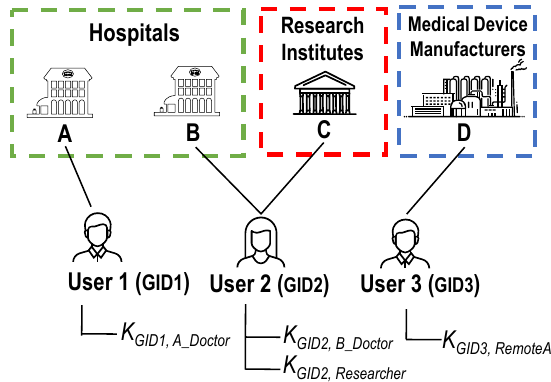
Figure 1. MA-ABE attribute binding and key